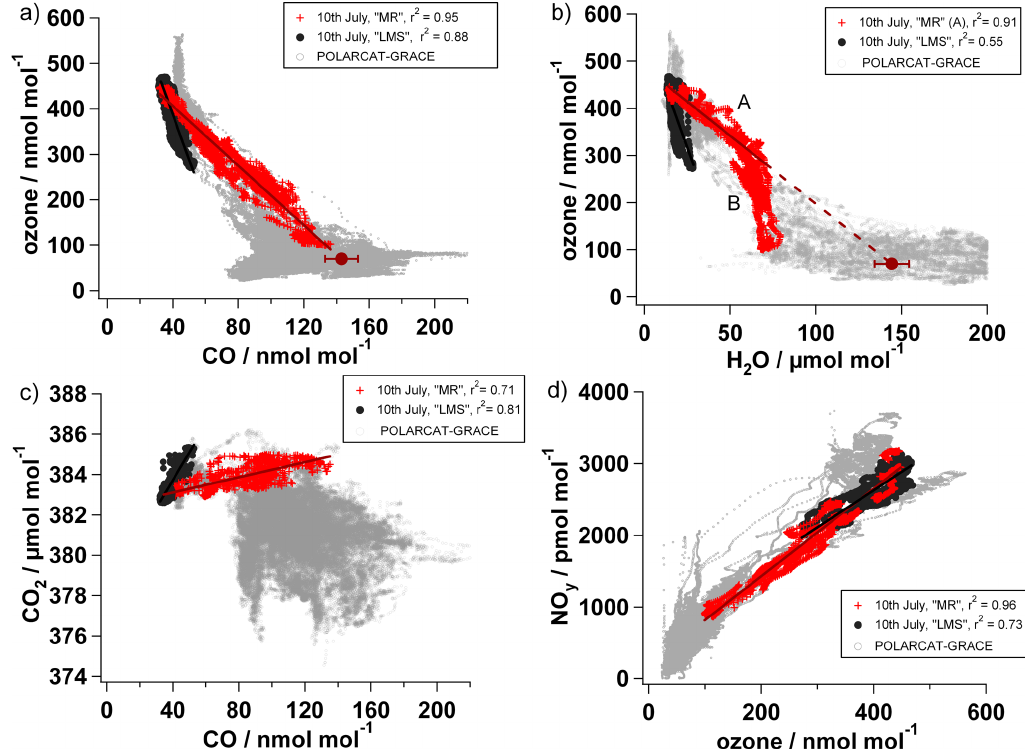
Fig. 9. Scatter plots of (a) O 3 vs. CO, (b) O 3 vs. H 2 O, (c) CO 2 vs. CO, and (d) NO y vs. O 3 . Data of the 10 July “MR” are shown as red crosses, the 10 July “LMS” data are given as black circles. Grey open circles represent all POLARCAT-GRACE measurements. See text for more